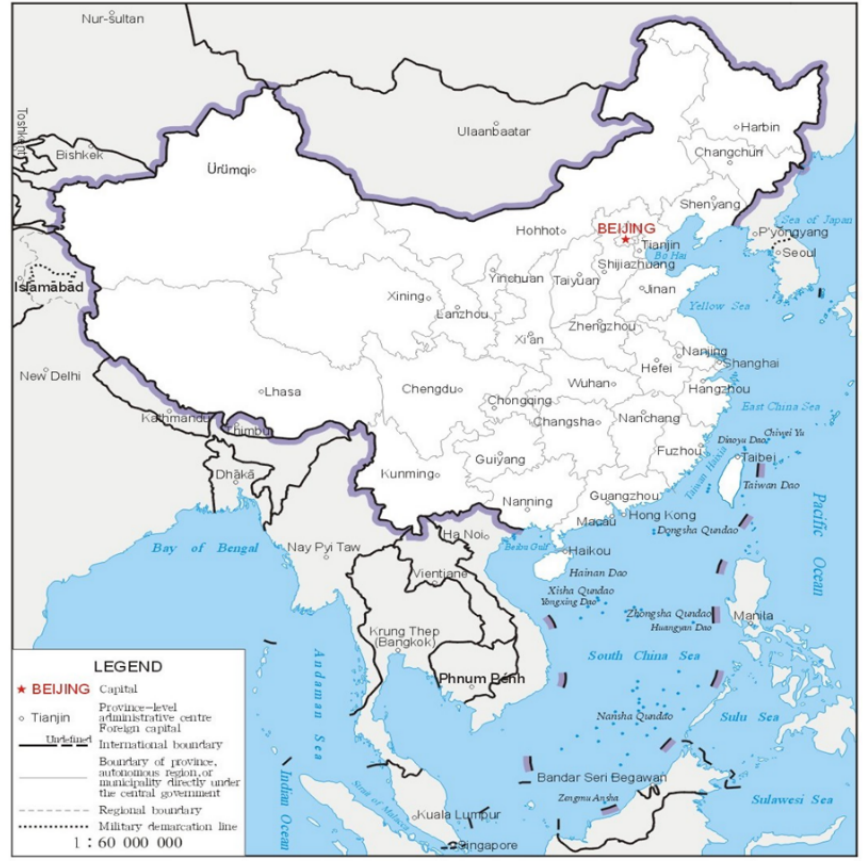
Figure 1. Location of the study aera; Drawing approval number: GS [2019]1652; Producer: Ministry of Natural Resources of China [23].